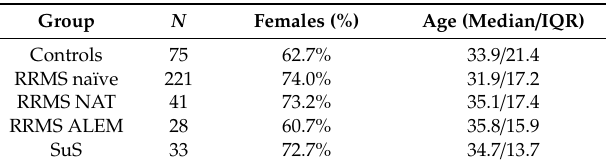
Table 1. Clinical characteristics of the examined groups.